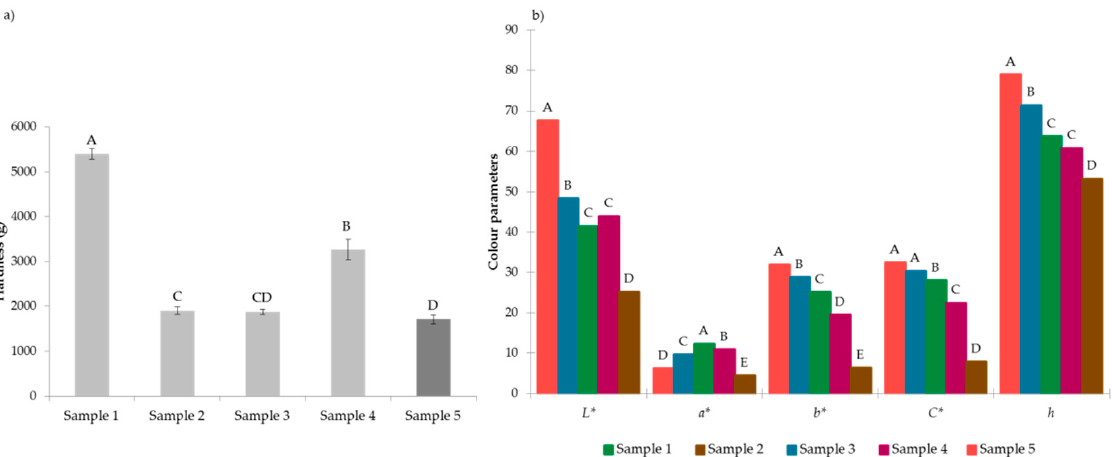
Figure 3. Textural properties (hardness) of protein bars ( a ); colour properties of protein bars ( b ); Sample 1–4: commercially available bars (Sample 1: protein 25.0 g; Sample 2: protein 5.2 g; Sample 3: protein 32.0 g; Sample 4: protein 14.2 g), Sample 5: created high-protein bar: protein 34.0 g. A, B, C, D above the bars indicate significant difference at p < 0.05